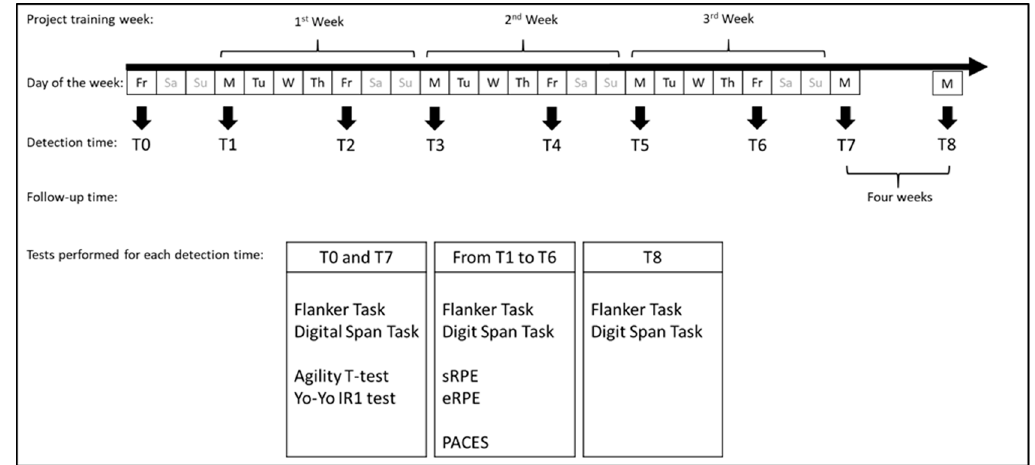
Figure 1. Timeline of the experimental procedures.